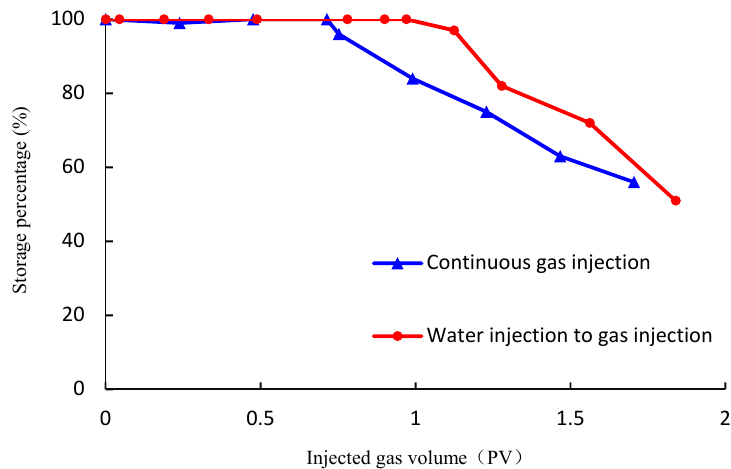
Figure 7. Relationship between injection mode and storage factor.